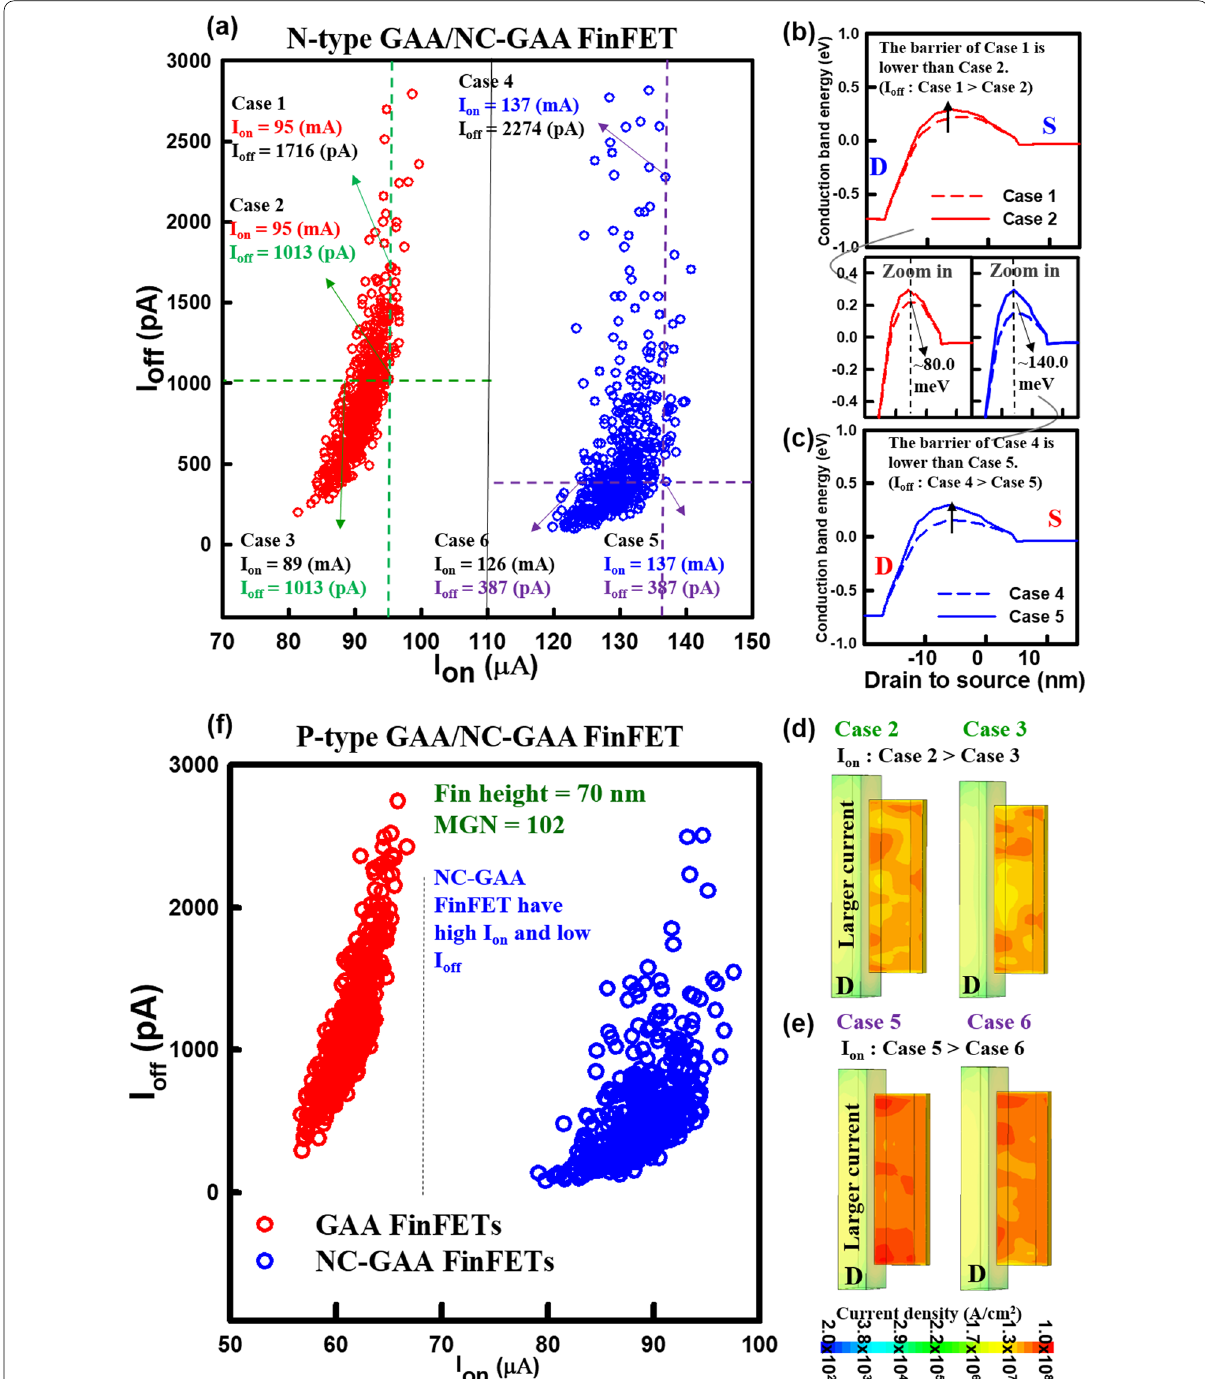
Fig. 10 a The characteristic of I on – I off for N‑type GAA and NC‑GAA FinFETs with the same MGN. The 1D conduction band energy profiles and the zoom‑in plots for b Cases 1 and 2 and c Cases 4 and 5 for GAA and NC‑GAA FinFETs. The distribution of current density for d Cases 2 and 3 and e Cases 5 and 6 for GAA and NC‑GAA FinFETs, respectively. f The characteristic of I on – I off for P‑type GAA and NC‑GAA FinFETs with the same